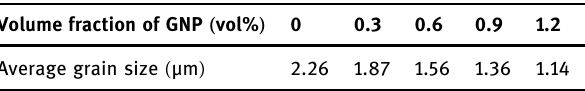
Table 2: Grain size of Al matrix in pure Al and GNP/Al composite. Reproduced from ref. [ 54